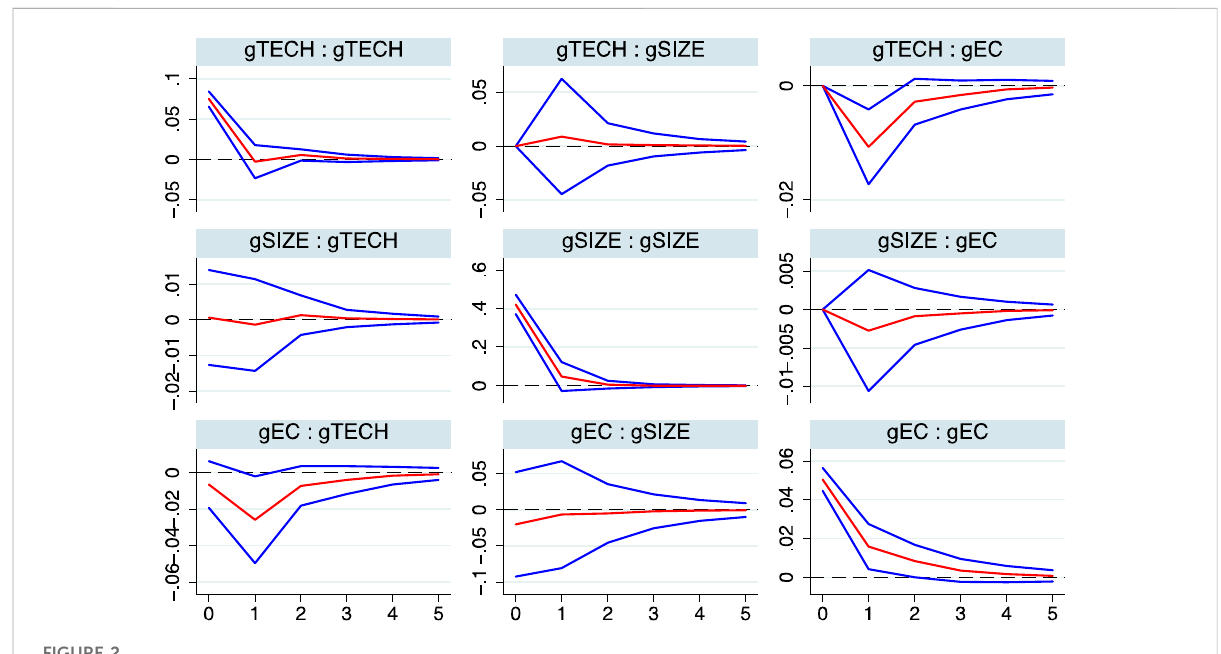
FIGURE 2 Orthogonalized impulse response (ordered by gEC gSIZE